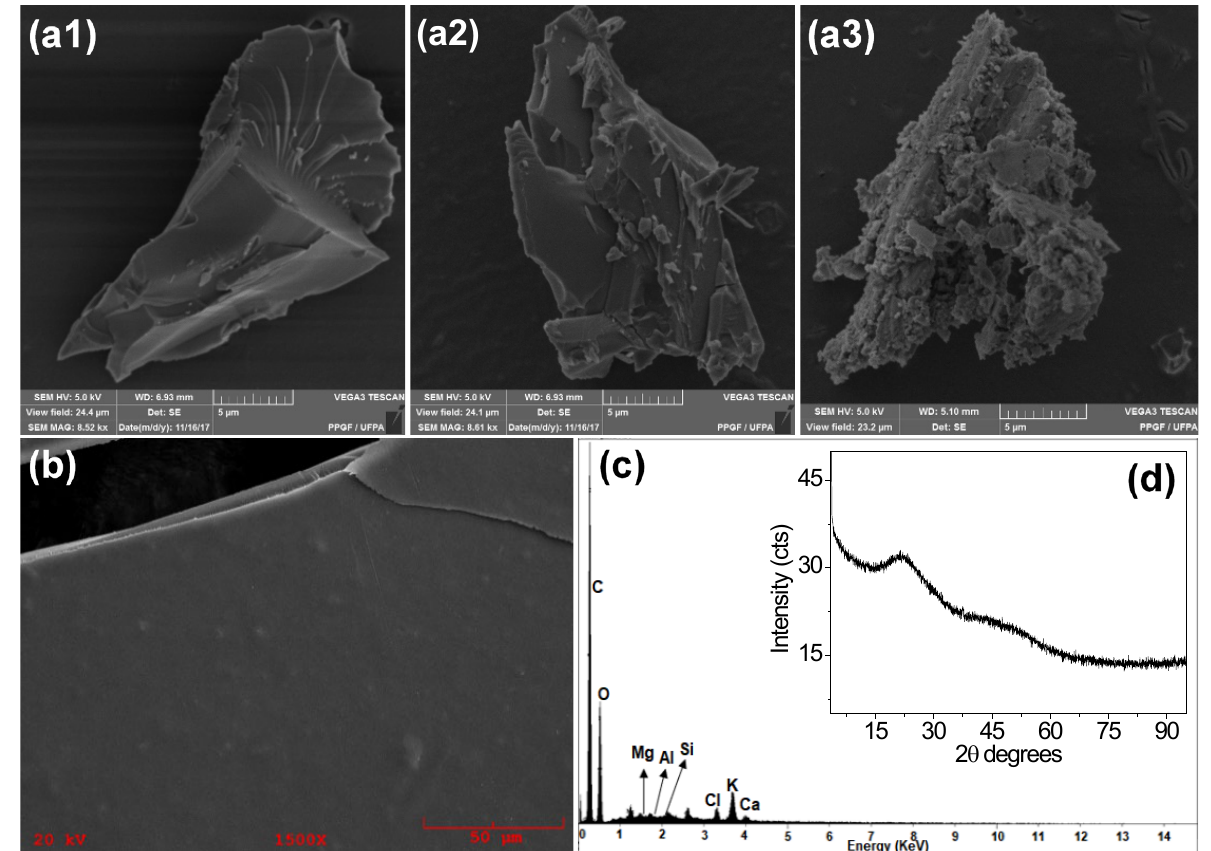
Figure 5. SEM images of ( a ) powdered BG ( b ) after drying at 50 °C for 24 h; ( c ) EDS spectrum and ( d ) XRD of the gum.